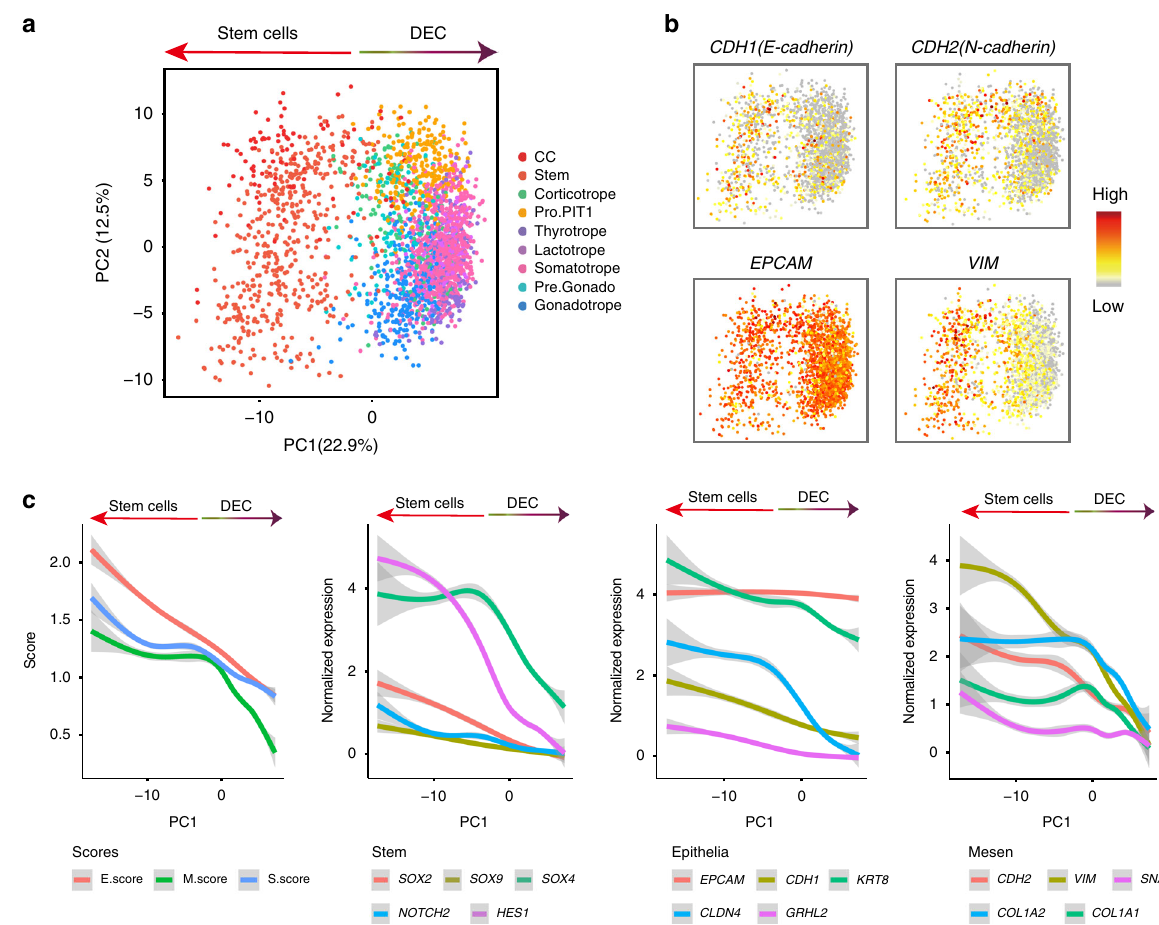
Fig. 3 Hybrid epithelial/mesenchymal state of pituitary stem cells. a PCA plot showing differentiation of endocrine cells along the PC1 axis. Dots: single cells; colors: cell types. b Scatterplots showing the expression of representative epithelial and mesenchymal markers projecting on the PCA plot. Gray to red indicate no to high expression levels. c The values of the epithelial score (E.score), the mesenchymal score (M.score), and the stemness score (S.score), as well as and the expression levels of representative genes, decreased during differentiation. The colored lines represent loess-smoothed expression. Data are presented as mean ±